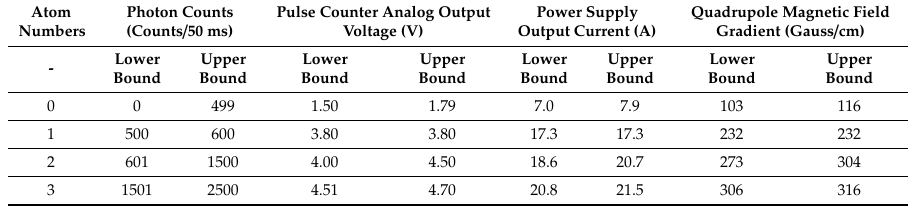
Figure 2. Single-atom loading trigger loop. ( a ) Pulse counter adjusts the output voltage according to different photon counts. We use the output analog voltage to control the output current of power supply and the quadrupole magnetic field gradient. Keys to (a) single-photon counting module (SPCM); insulated gate bipolar transistor (IGBT); ( b ) The trigger loop dynamically changes the loading rate of atoms in the MOT by adjusting the quadrupole magnetic field gradient. Table 1. Pulse counter and power supply parameter setting.